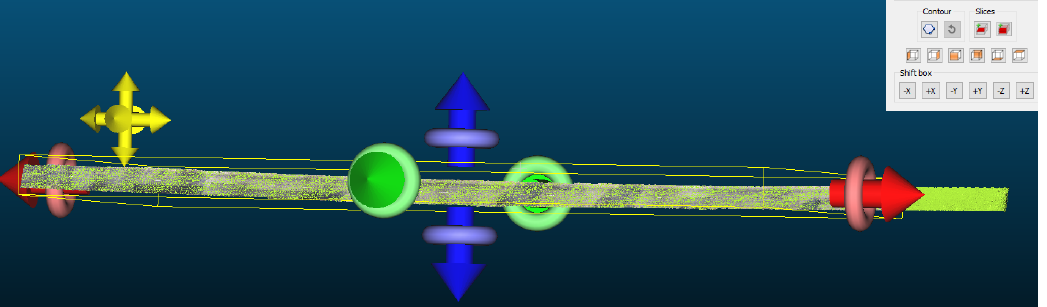
Figure 20. Generating cross-sections of model.